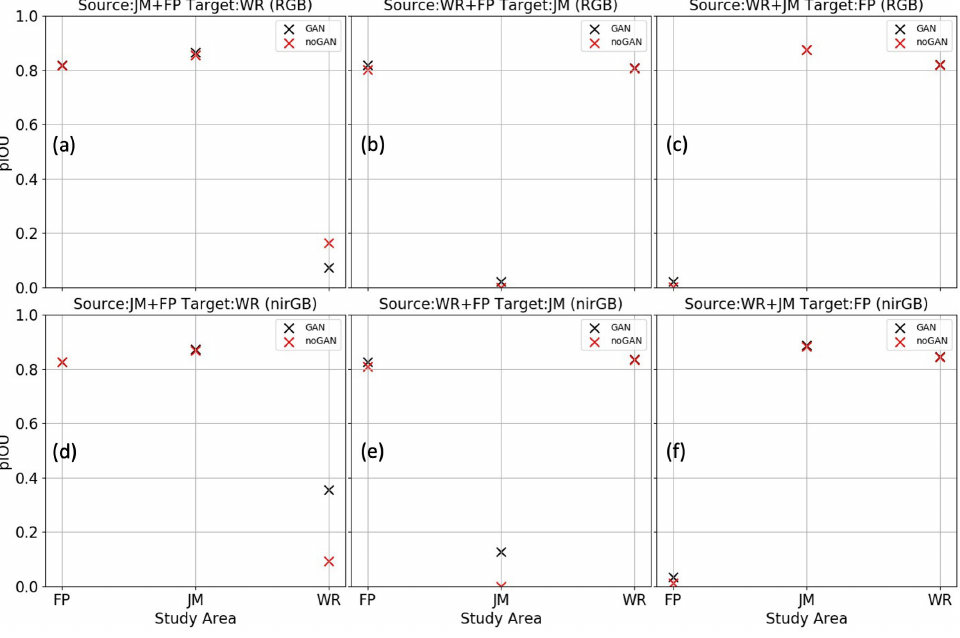
Figure 11. Comparison of the accuracy (pIOU) among experiments with and without GAN domain adaptation for images acquired in different study areas. ( a – f ) show the accuracies of different experiments. WR: Willow River, JM: Jesse Moraine, FP: Fosheim